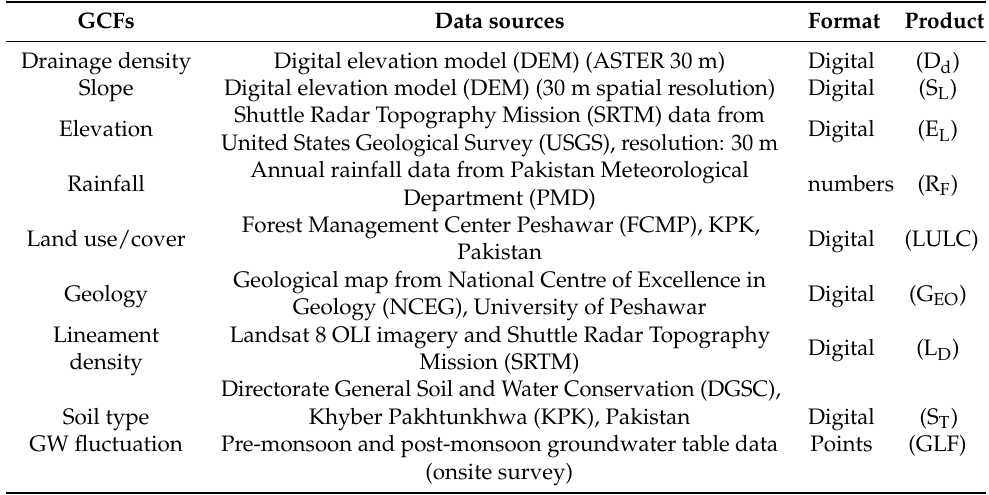
Table 2. GCFs used for mapping groundwater potential of the Karak watershed. GCFs Data sources Format